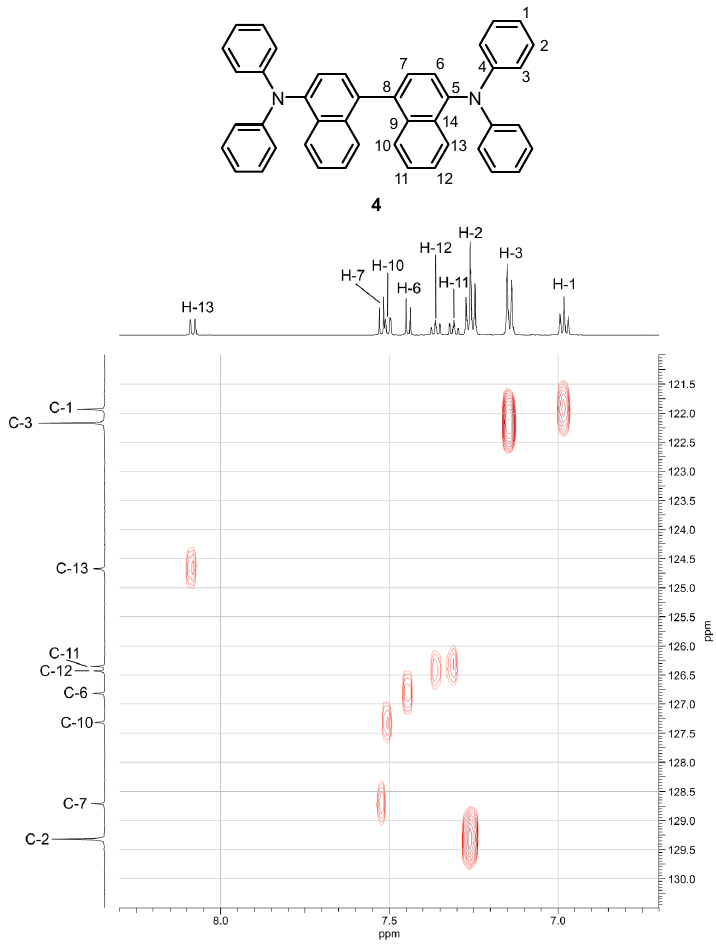
Figure 2. Assignment of the 13 C-NMR signals of the N , N , N ’, N ’-tetraphenylnaphthidine ( 4 ) to the respective 1 H-NMR signals by the HSQC spectrum.